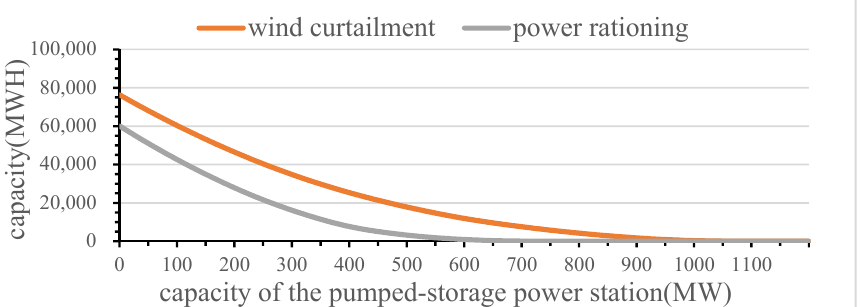
Figure 7. Input capacity and curtailment of wind and power rationing in the off-peak period of heating.